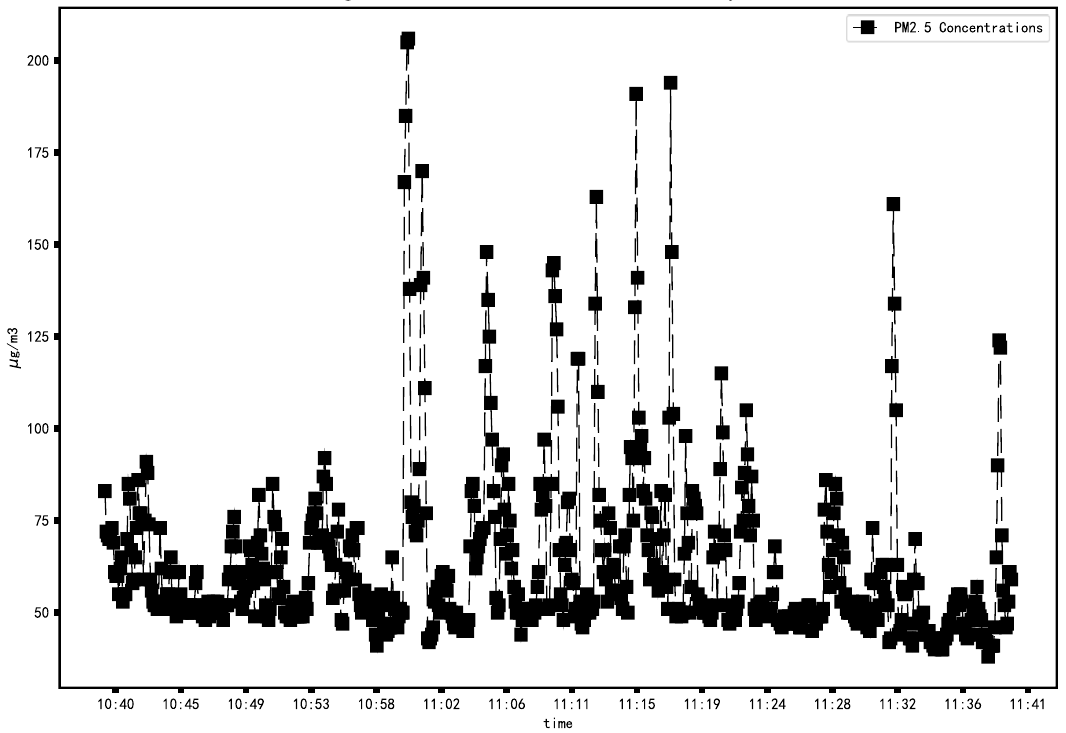
Fig 12. PM2.5 concentration change from 10:40 to 11:40 on October 18, 2021.